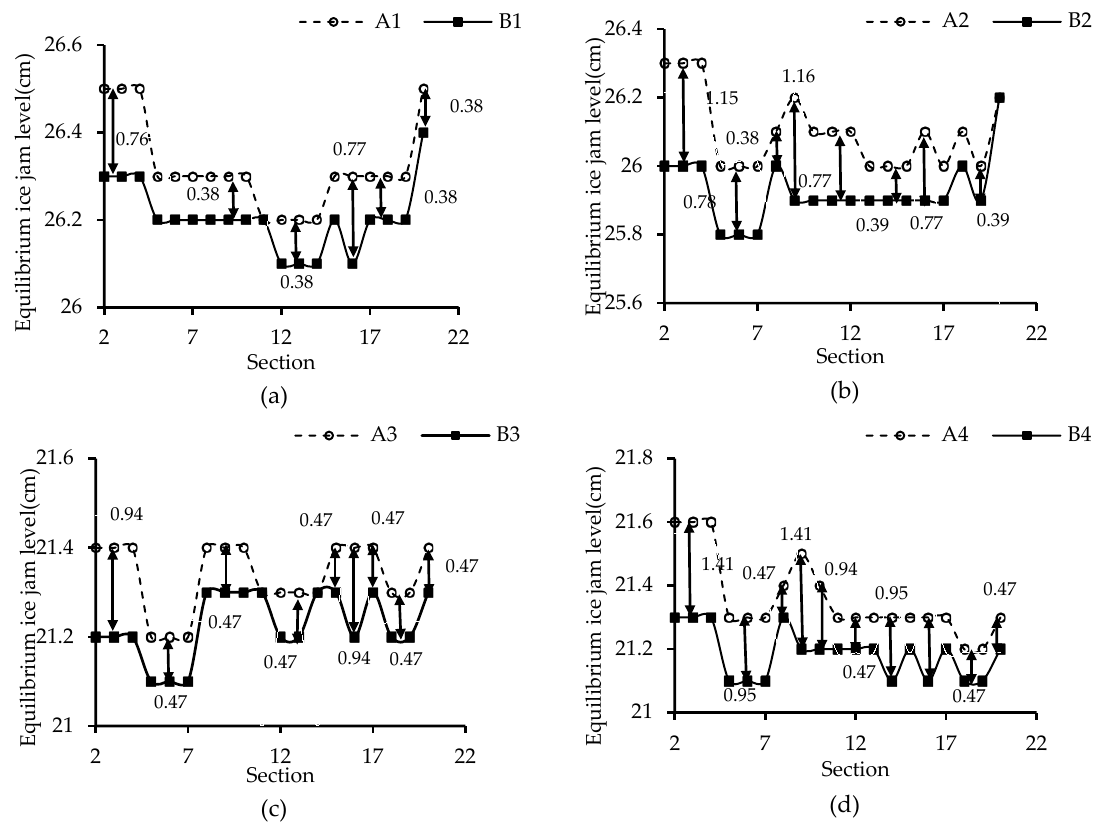
Figure 9. Comparison of water levels during an equilibrium ice jam with a local scour around the pier to those without a local scour. The numbers in Figure 9 show that when the water level for an equilibrium ice jam without the presence of a local scour is used as the benchmark value, the rate of increase in water level for an equilibrium ice jam with the presence of a local scour condition is in %. (( a ): H 0 = 0.25 m, V 0 = 0.17 m/s; ( b ): H 0 = 0.25 m, V 0 = 0.15 m/s; ( c ): H 0 = 0.20 m, V 0 = 0.17 m/s; ( d ): H 0 = 0.20 m, V 0 = 0.15 m/s).